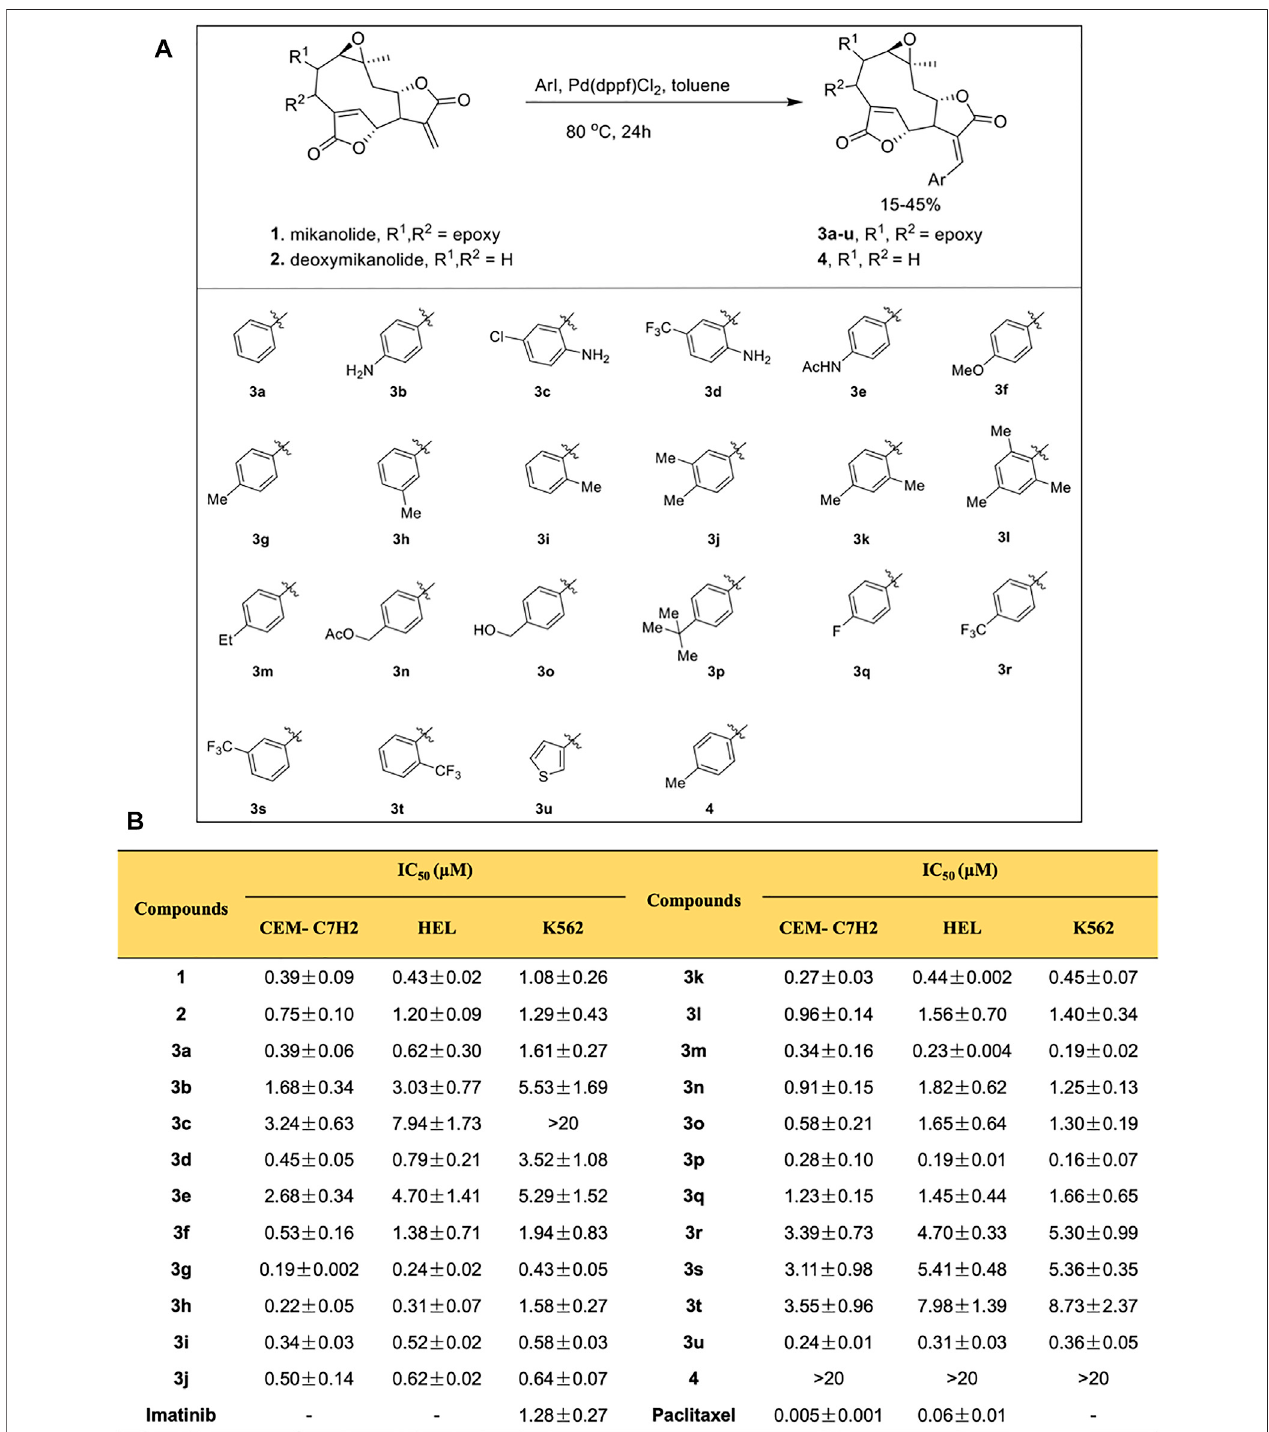
FIGURE1| Mikanolidederivativesofferantileukemicaction. (A) Schematicdiagramexplainingtheprocedureofsynthesisofmikanolidederivatives. (B) Cytotoxicity (IC 50 ) of mikanolide derivatives against indicated cancer cells. Data represented as means ± SD of three independent experiments.